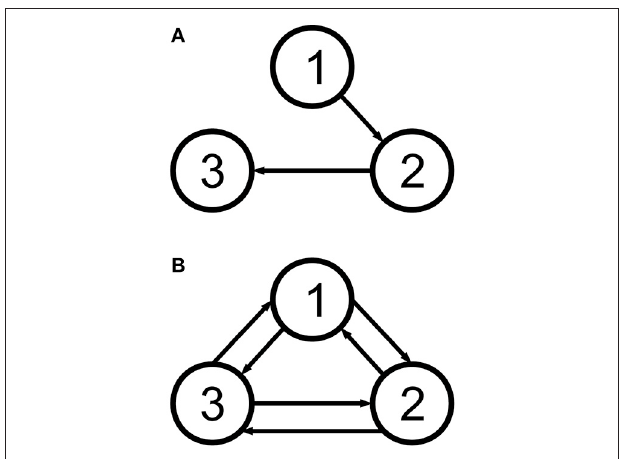
FIGURE 2 | The two cortical column motifs used in this paper. Unidirectionally coupled cortical columns have no backflow (A) , and bidirectionally coupled columns are coupled all-to-all (B) . See Table 3 .